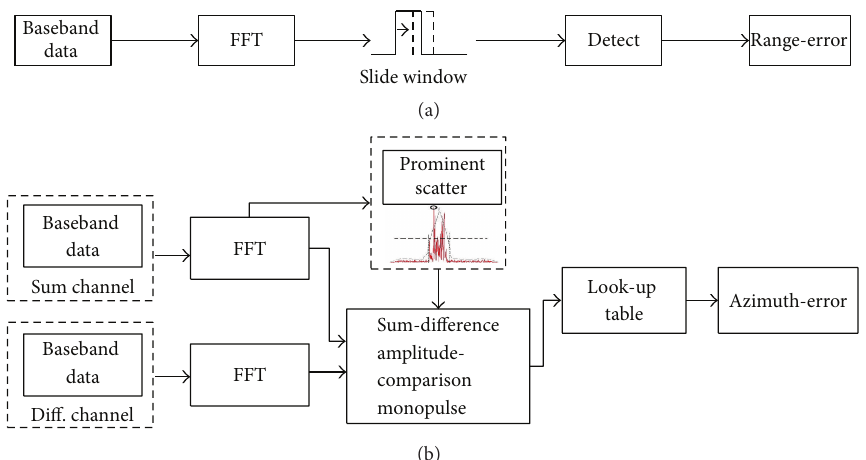
Figure 3: Basic block diagram of range and azimuth tracking. (a) Basic block diagram of range tracking. (b) Basic block diagram of azimuth tracking.